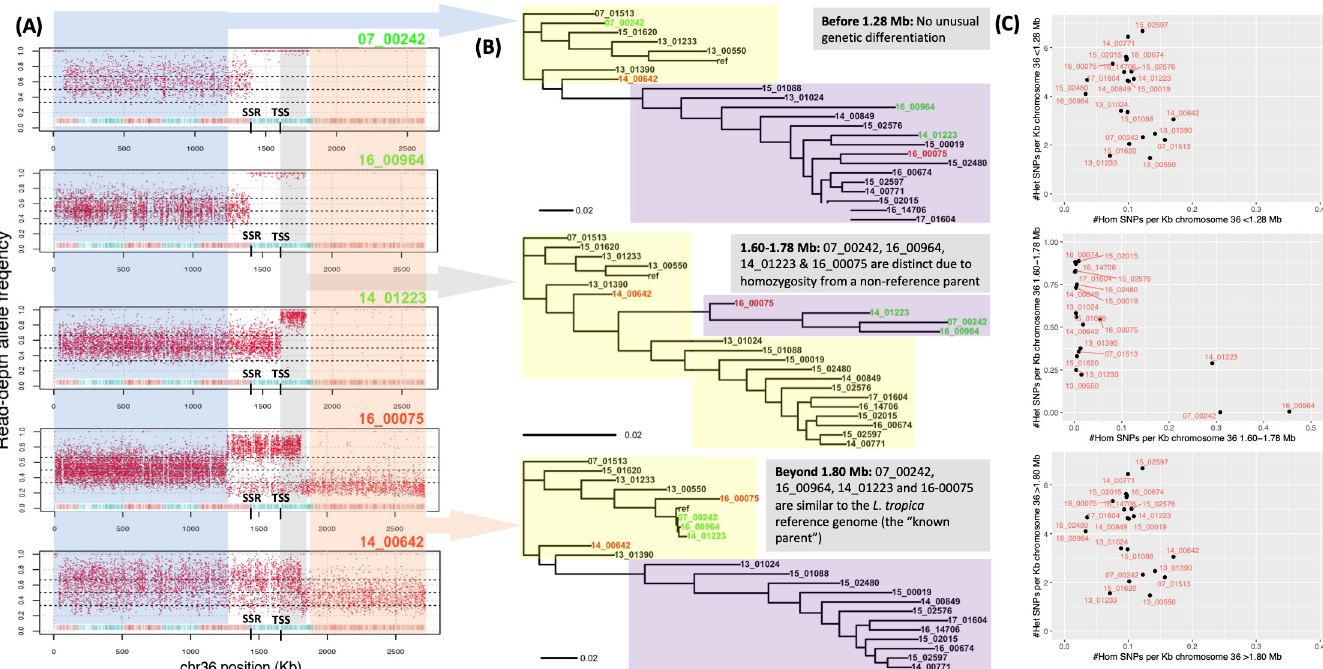
Fig 3. RDAF distributions (A) and phylogenies (B) constructed from SNPs at the 5’-end of chromosome 36 ( < 1280 Kb, blue RDAF, top phylogeny), middle (1600–1780 Kb, grey RDAF, middle phylogeny) and 3’ end ( > 1800 Kb, orange RDAF, bottom phylogeny) showing the genetic relatedness of the 22 isolates with the L . tropica reference genome (“ref”). (A) Patterns of heterozygosity (blue), a LROH (grey) and homozygous similarity (orange) are seen in 14_01223, 07_00242 and 16_00964 (green), and high heterozygosity in 16_00075 and 14_642 (red). All isolates were disomic for chromosome 36, except 14_00642 that was trisomic. The putative TSS inferred from L . major is at 1.63 Mb (black), corresponding to a recombination breakpoint in 14_01223 (middle). 07_00242 (top) and 16_00964 (second) had breakpoint at an inferred strand-switch region (SSR) at 1.42 Mb. (B) The inferred genetically distinct groups are represented by the L . tropica reference (yellow area) and non- reference groups (purple area). (C) The homozygous (x-axis) and heterozygous (y-axis) SNPs/Kb for all 22 samples for the 0–1.28 Mb region (top), 1.60–1.78 region (middle) and > 1.8 Mb region (bottom).